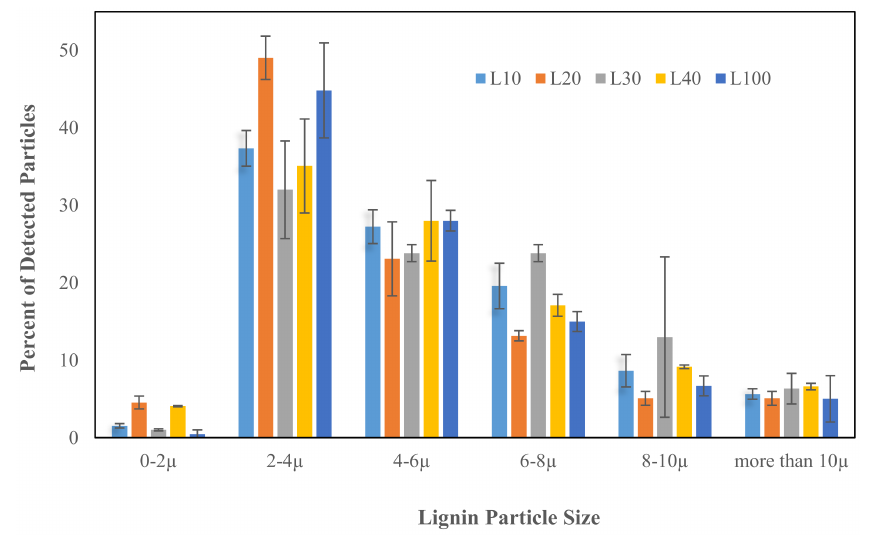
Figure 1. Distribution of lignin particle size after different grinding cycles, obtained by analysis of images, taken using oCelloScope and UniExplorer